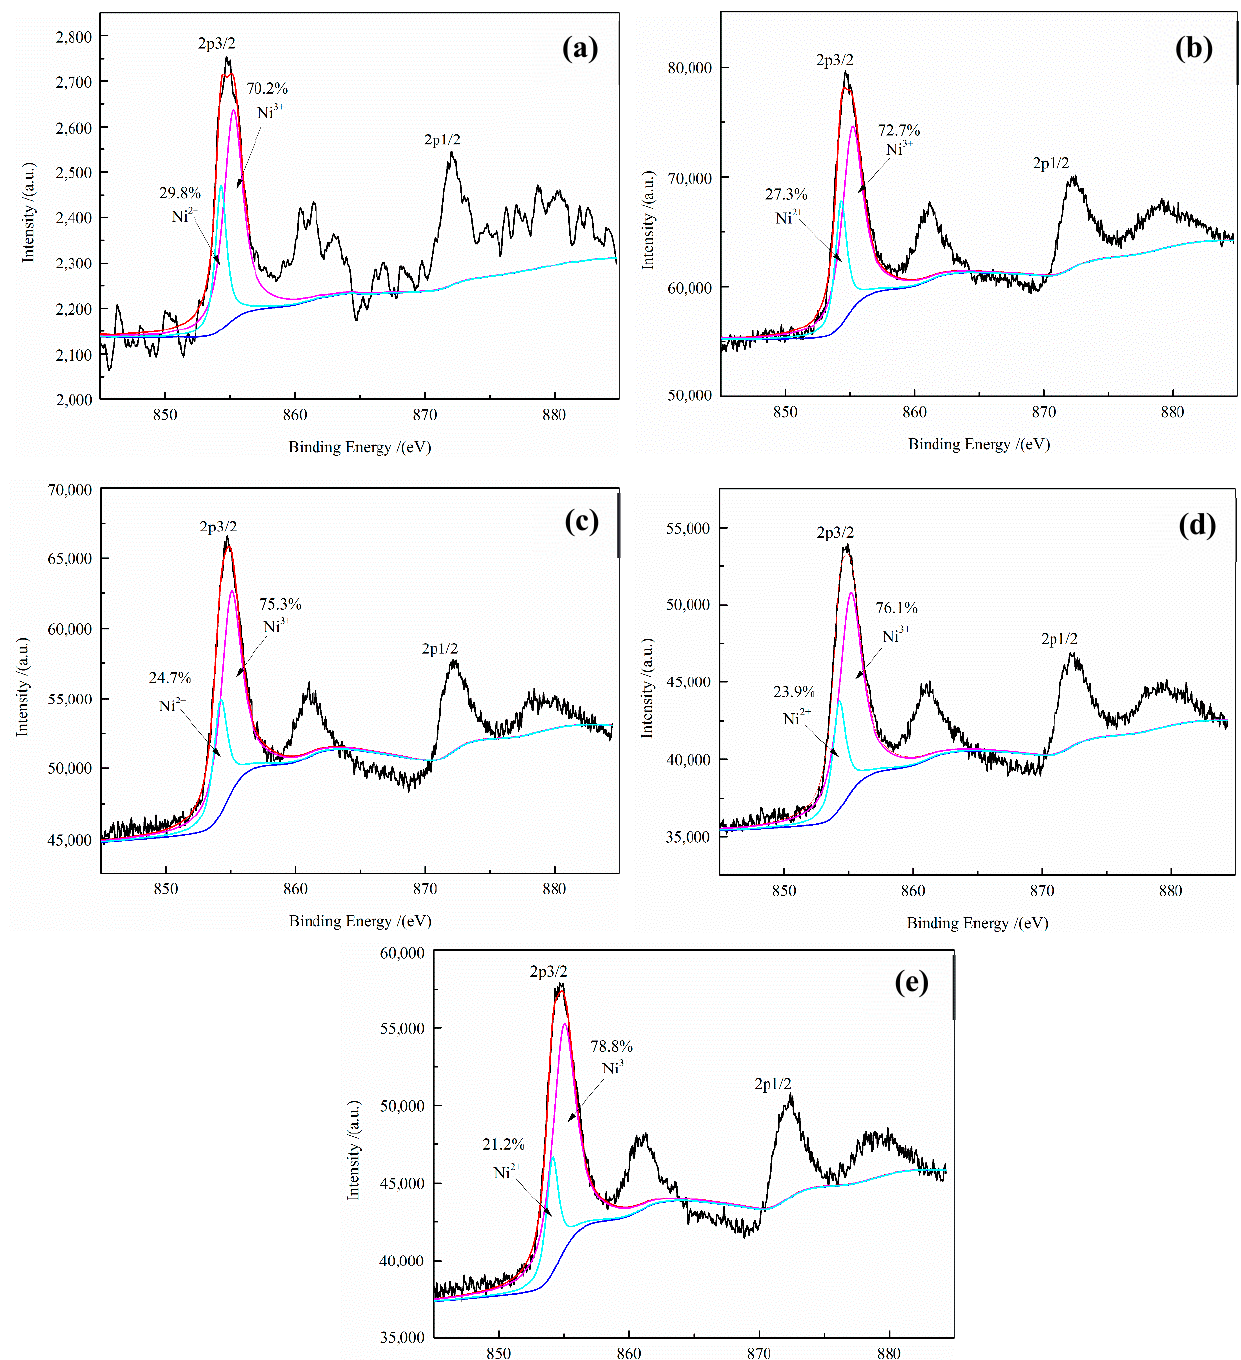
Figure 5. Ni2p XPS patterns of ( a ) LMNCO, ( b ) nLMNCO-1.0, ( c ) nLMNCO-2.0, ( d ) nLMNCO-3.0, and ( e ) nLMNCO-4.0 cathode materials.